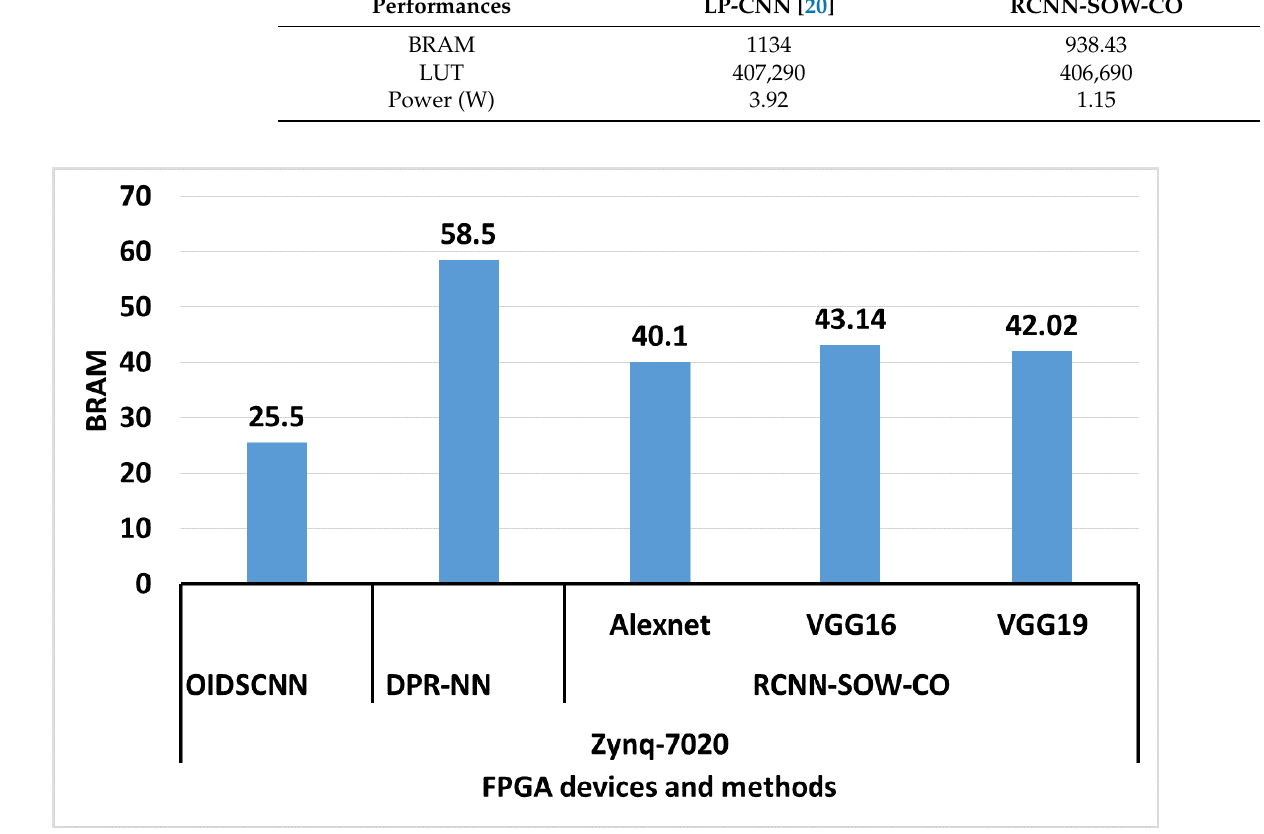
Figure 21. Comparison of BRAM. OIDSCNN [17], DPR-NN [23].